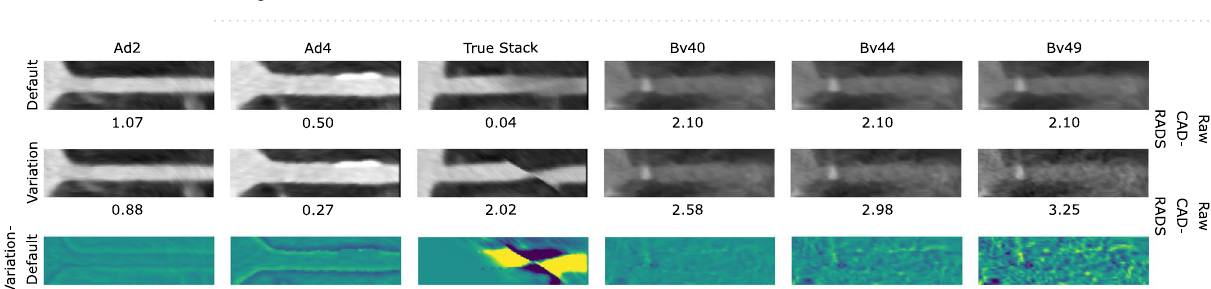
Figure 6. Proximal RCA segments for the cases with the largest CAD-RADS prediction deviation for each parameter configuration (note that the same patient showed the largest deviation for all possible kernel choices). Raw predictions with propagated preprocessing results are displayed for each respective